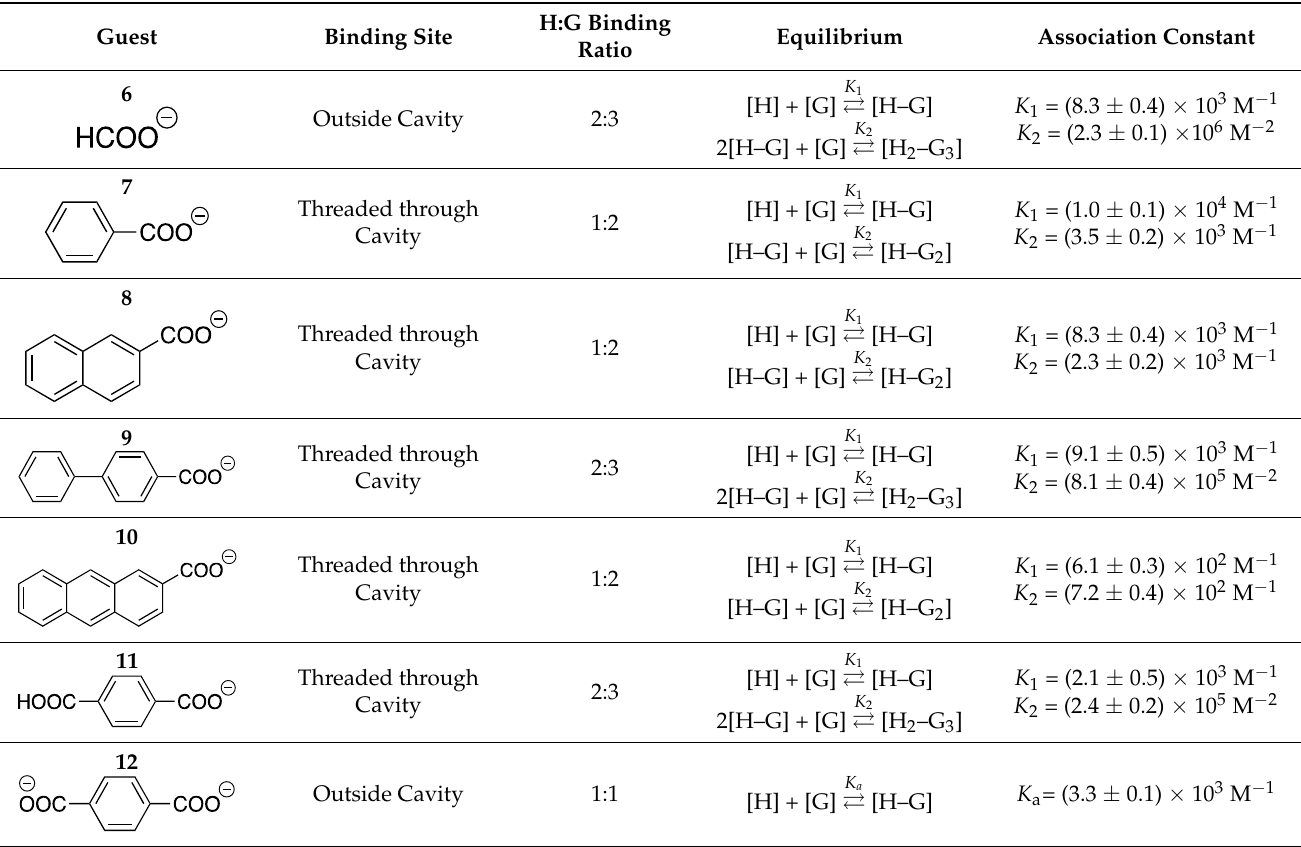
Table 1. Summary of host–guest binding properties of 1 with a wide range of guests in DMSO- d 6 [47,48].